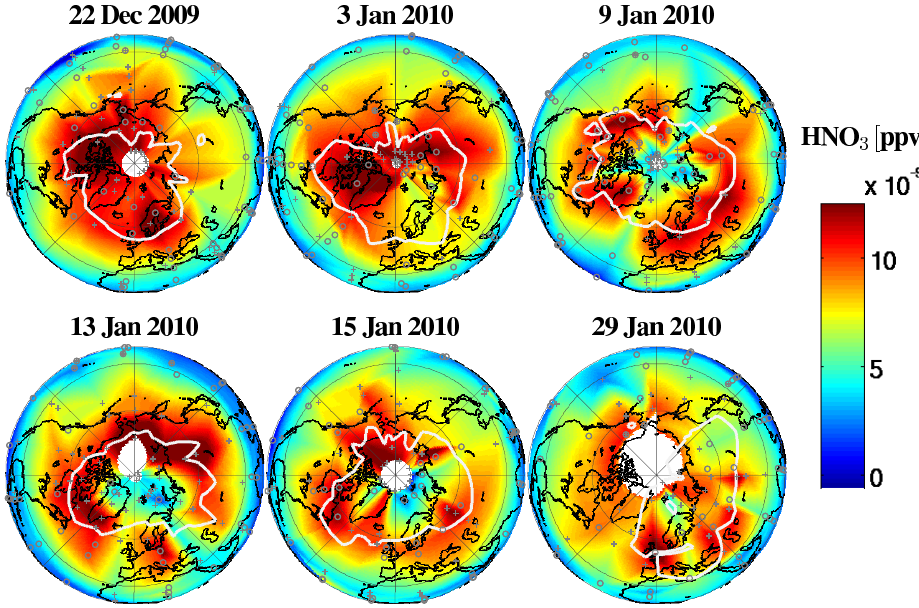
Fig. 1. Global distributions of HNO 3 derived from Odin/SMR observations for the 22 December, 3, 9, 13, 15 and 29 January at 525K. The white line is the 125ppbv contour of N 2 O, chosen to indicate the edge of the polar vortex.